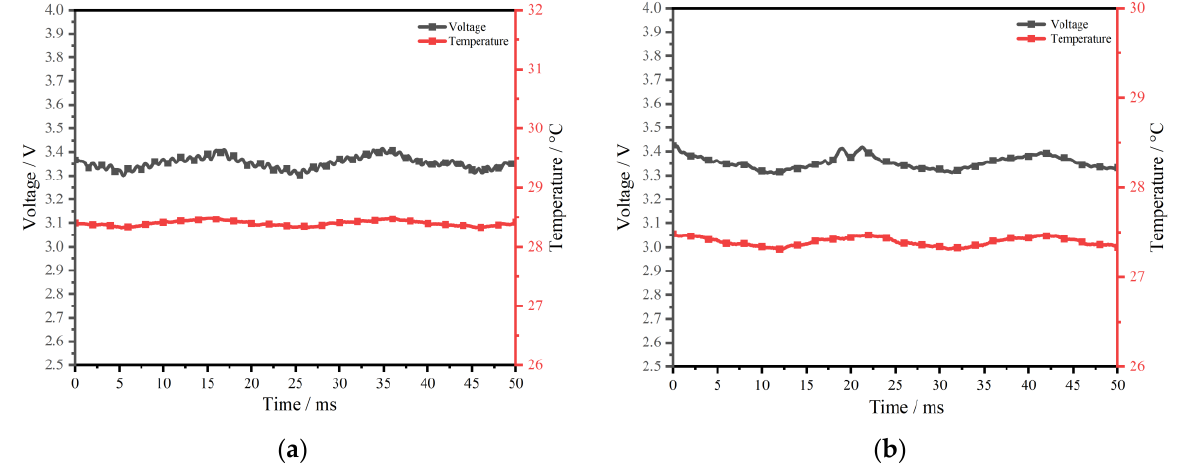
Figure 8. Voltage-temperature- time curve of the battery at Z− positions. ( a ) Test results at Z3− position; ( b ) Test results at Z4− position.